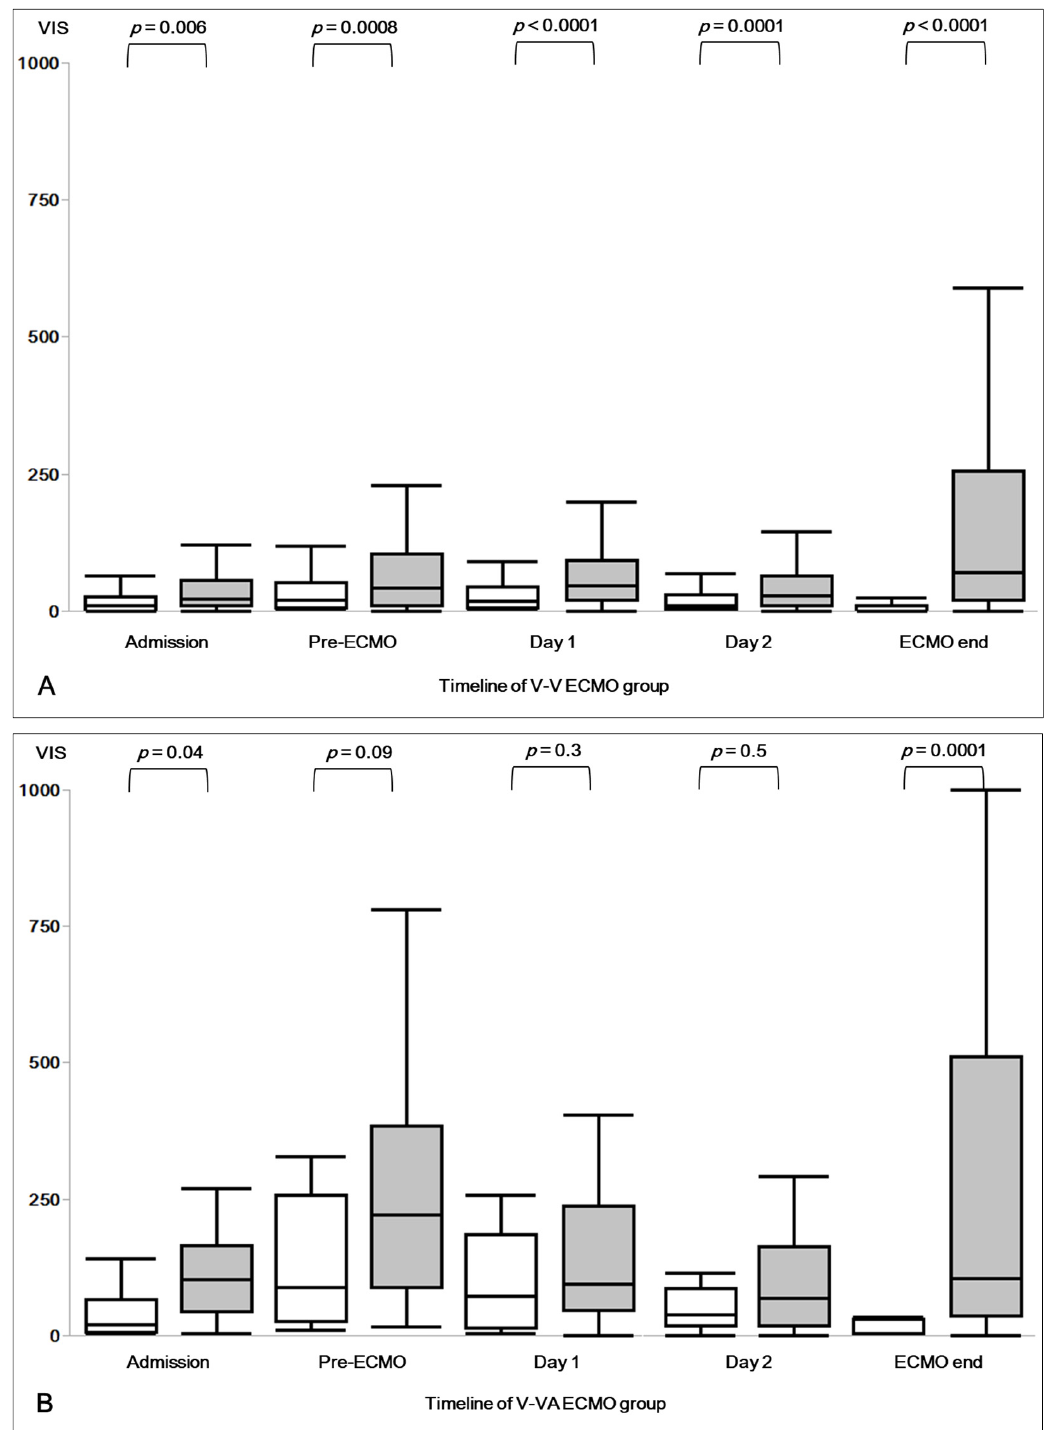
Figure 1. Trend in VIS in ( A ) V-V ECMO and ( B ) V-VA ECMO both for survivors (white) and non-survivors (gray). Boxplots show median and interquartile range Q1–Q3, brackets denote the differences between survivors and non-survivors, p -values are shown above the brackets. VIS = Vasoactive Inotropic Score; ECMO = Extracorporeal Membrane Oxygenation; V-V = Veno-Venous ECMO; V-VA = Veno-VenoArterial ECMO; pre-ECMO: immediately prior to ECMO initiation; ECMO end: immediately prior to the termination of ECMO support.